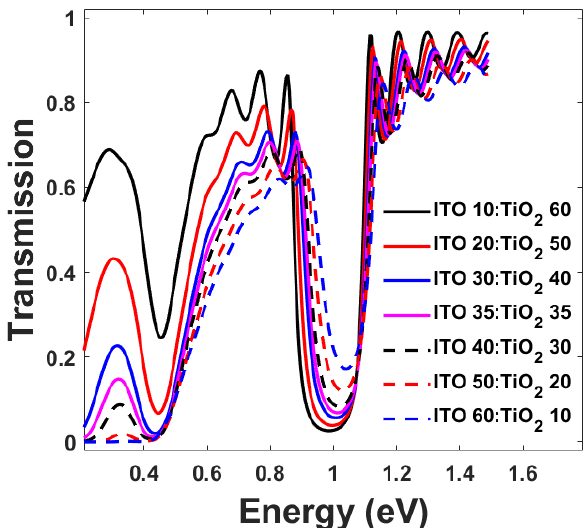
Figure 3. Light transmission spectra of ITO:TiO 2 :air/SiO 2 :air multilayer photonic crystals with different ITO:TiO 2 ratios, keeping constant the sum of 𝑓 𝐼𝑇𝑂 + 𝑓 𝑇𝑖𝑂